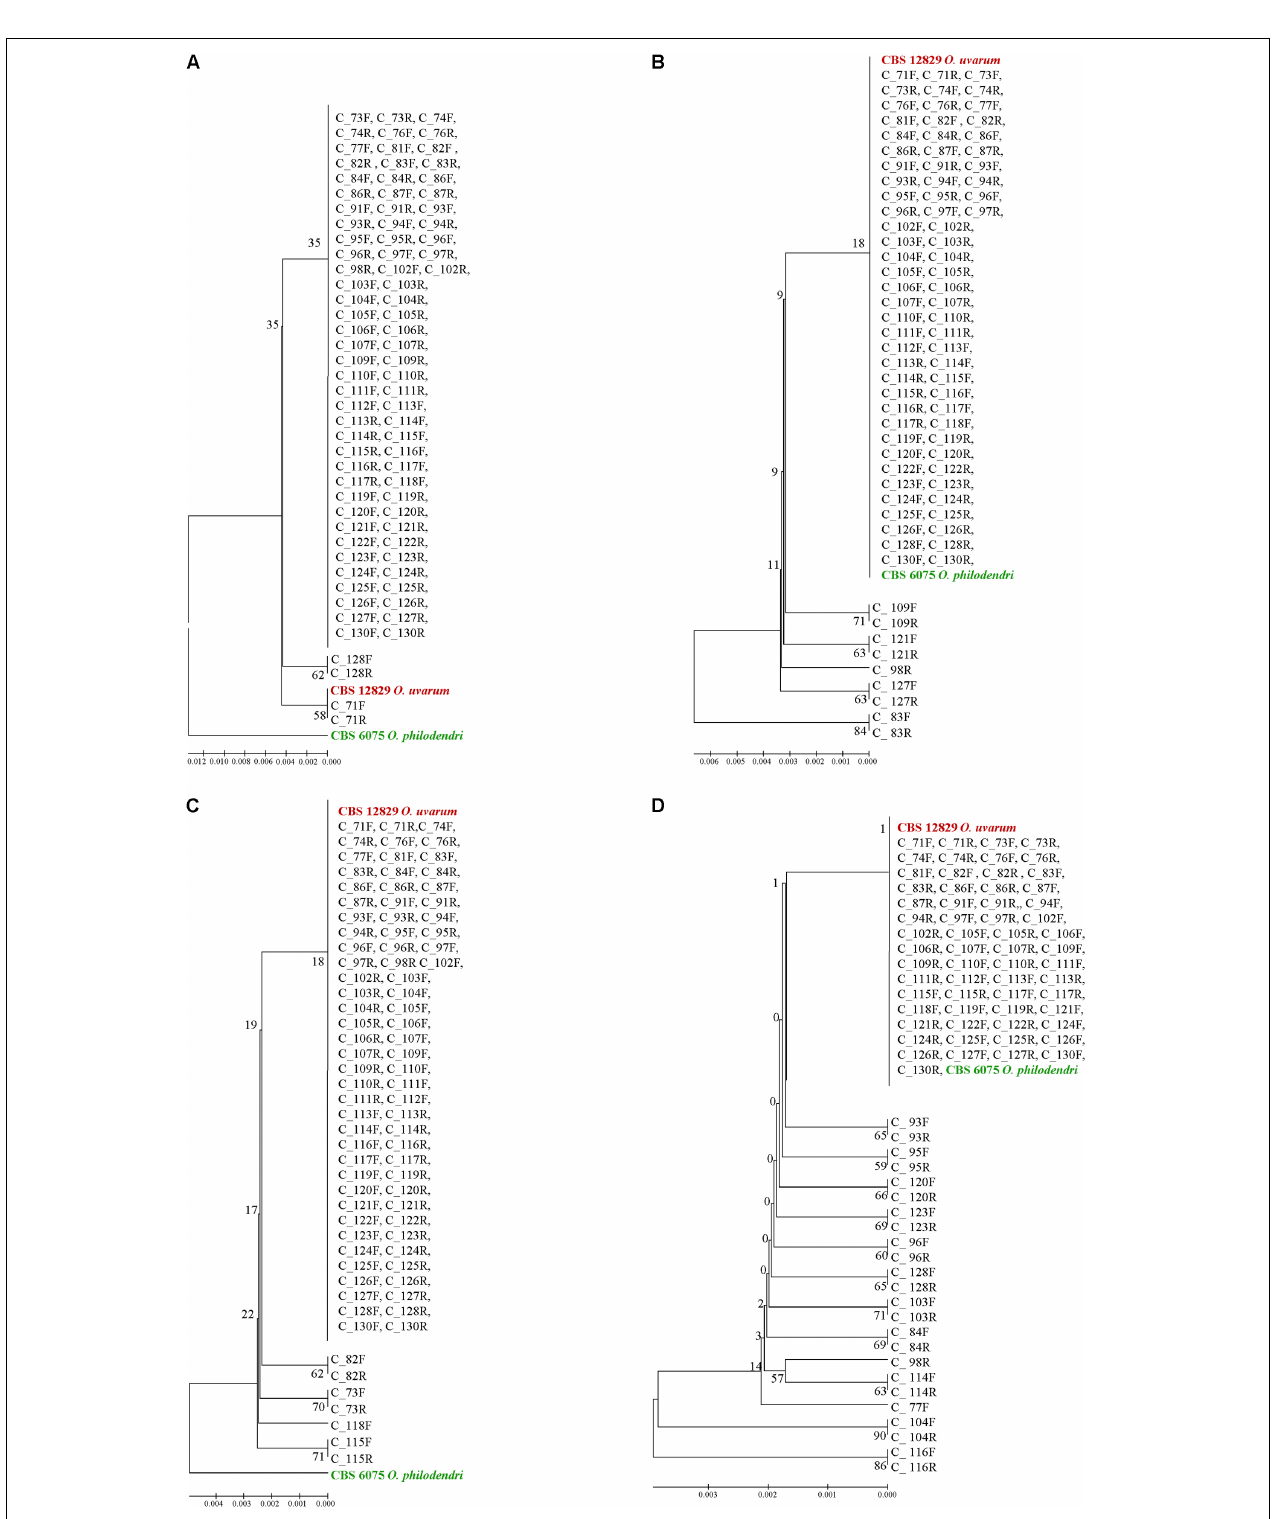
FIGURE 7 | UPGMA phylogenetic trees based on ITS1 (A) , 5.8S (B) , ITS2 (C) , and LSU (D) aligned sequences. The evolutionary distances were computed using the Maximum Composite Likelihood method expressed as number of base substitutions per site. UPGMA trees were obtained using the Maximum Composite Likelihood with MEGA6; bootstrap support values were calculated with 100 replicates and are shown next to the branches. GenBank deposit numbers are reported in Supplementary Table S1 .